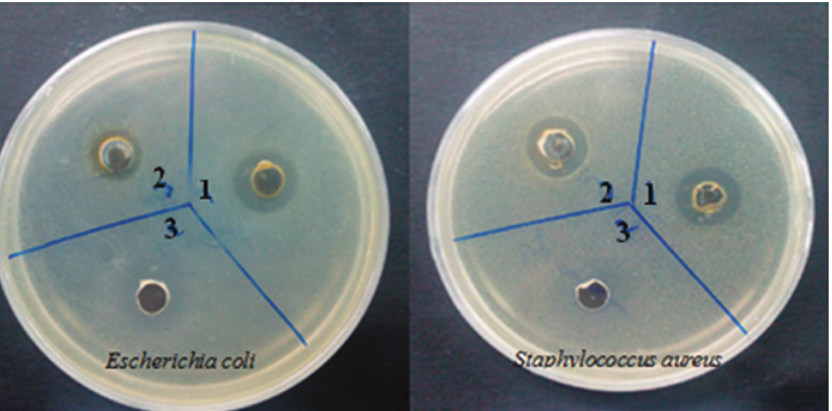
Figure 9: Created zones of inhibition with Staphylococcus aureus and Escherichia coli incubated at 37 ° C for 24 h for (1) chitosan solution containing silver nanoparticles (AgNPs), (2) chitosan solution and (3) distilled water.